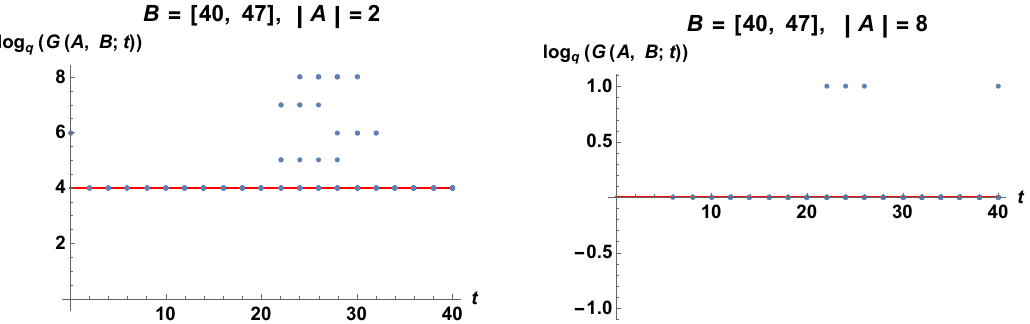
Figure 17 . We consider a system with L = 80 , and sites labelled from x = 0 to x = 79 . We fix the region B = [40 , 47] , and look at G ( A, B ; t ) for different choices of A . We consider intervals with | A | = 2 < | B | / 2 on the left, and | A | = 8 > | B | / 2 on the right, and in both cases we sample over a large number of intervals A and show log ( G ( A, B ; t )) as a function of time in a single plot with q the blue data points. The value expected from the random void distribution (3.9) is 4 in the first case, and 0 in the second case. We see clearly that G ( A, B ; t ) ≥ G RVD ( A, B ; t ) , and there are